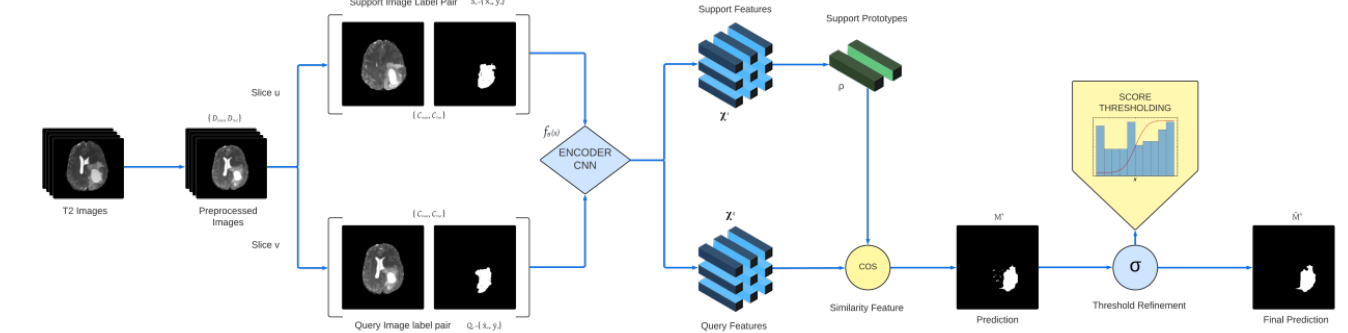
Figure 1. A pipeline of the proposed prototypical one-shot segmentation model to separate brain tumor regions.